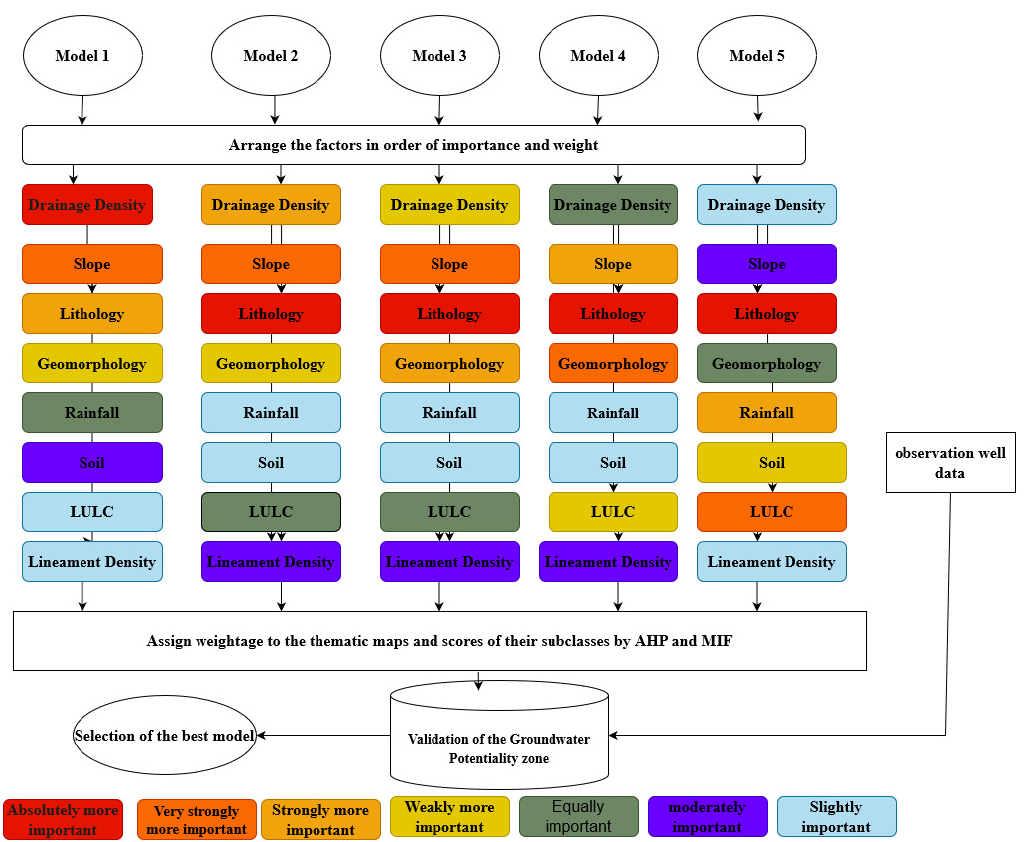
Figure 3. Flow chart of the methodology used to select the best model.